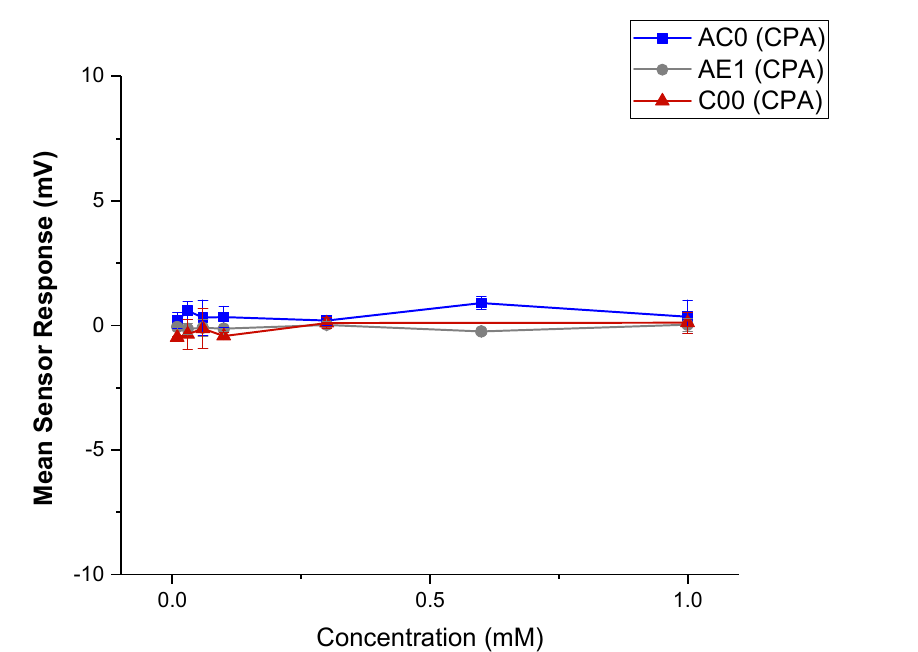
Figure 12. Sensor response curve of pure CBZ in 10 mM KCl (with 10% v / v ethanol); Mean responses of the AC0, AE1 and C00 sensors reflecting initial taste.